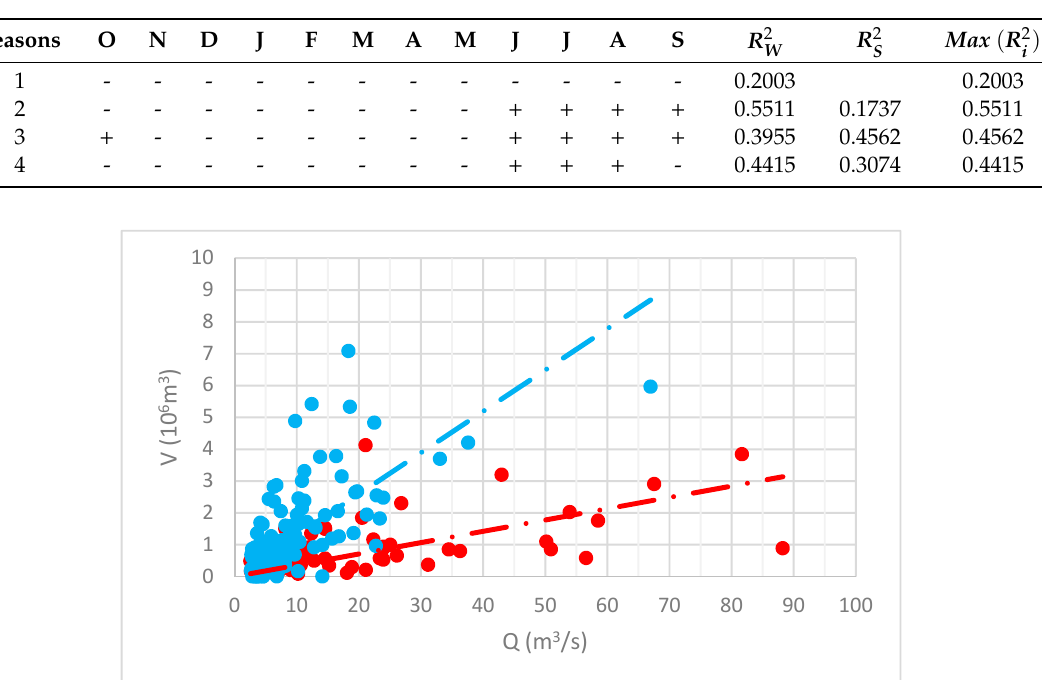
Figure 5. Regression through the origin (RTO) linear regressions over ( Q , V ) pairs. Winter (blue) and summer (red).